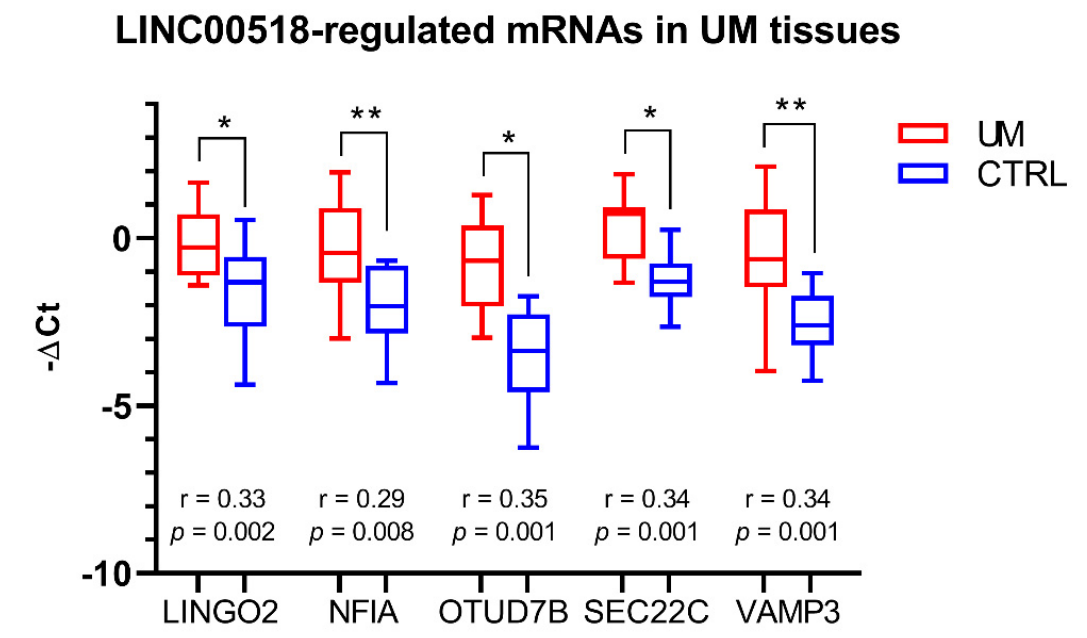
Figure 7. Expression of LINC00518 -regulated mRNAs in UM biopsies. For each mRNA, the r-value and the associated p -value measuring correlation of expression with LINC00518 are reported. Analysis was performed in 41 pairs of tumor and normal tissues. *: p -value < 0.05; **: p -value < 0.005.